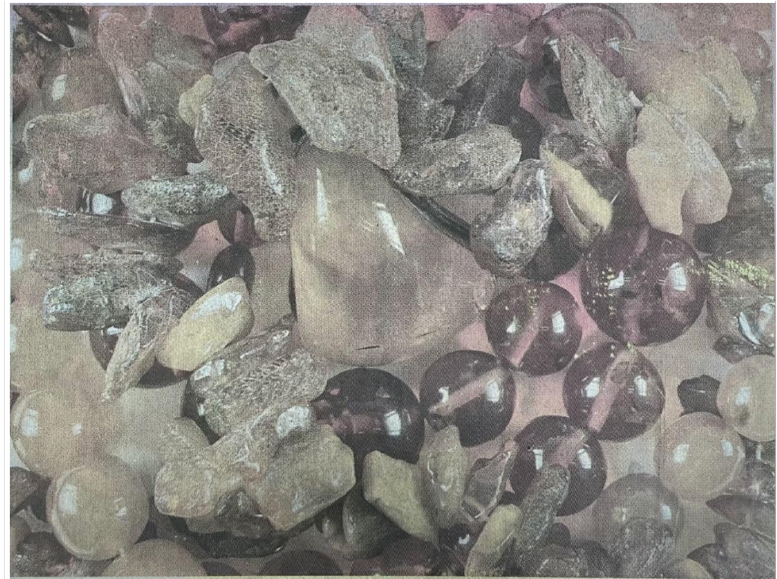
Figure A9. 25LPI, direct litho, Spectraval™ pigments, R,G,B, black Plike, film negative, print size: 600 mm × 450